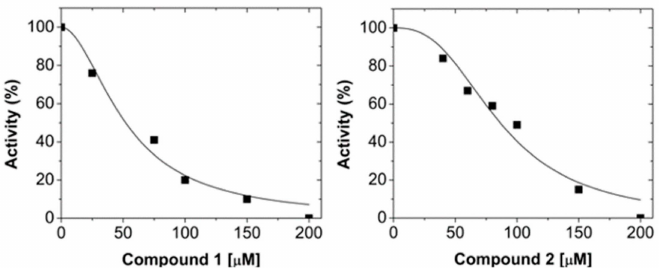
Figure 1. Inhibition kinetics of recombinant LmARG by compounds 1 and 2 .